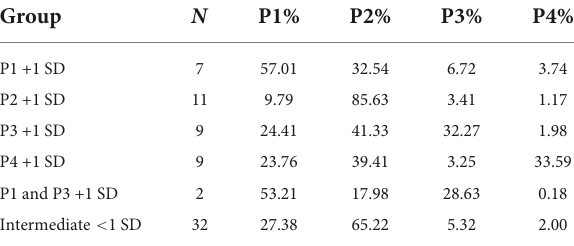
TABLE 6 Mean percentages of individual deck choices (week 5) in the rGT for each subgroup of extreme individuals in each choice based on +1 standard deviation